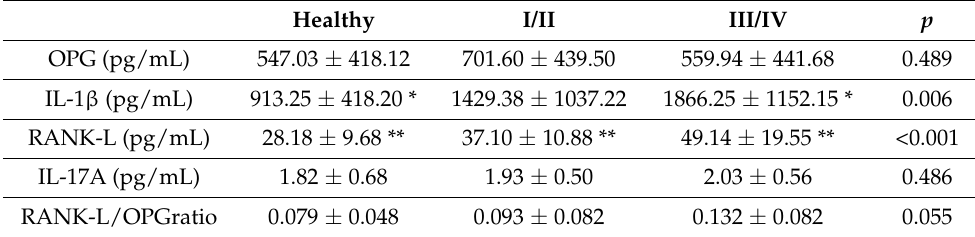
Table 3. OPG, IL-1 β , RANK-L, and IL-17A salivary levels in periodontally healthy and periodontitis I/II–III/IV